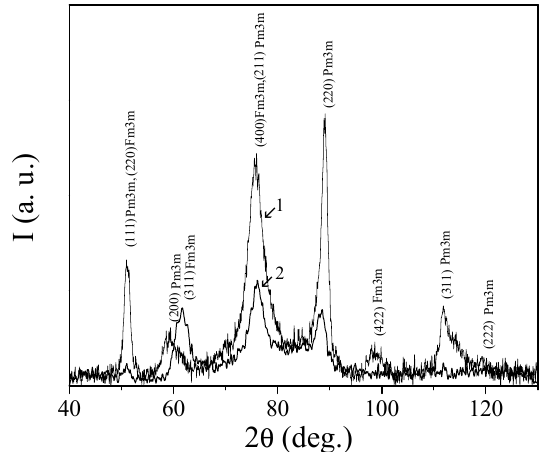
Figure 45. X-ray diffraction patterns of Ni 63.8 Mn 11.1 Ga 25 samples annealed at Т = 500 °C for 30 min. 1—glass-coated samples; 2—uncoated samples. Reproduced from reference [128], Figure 2.